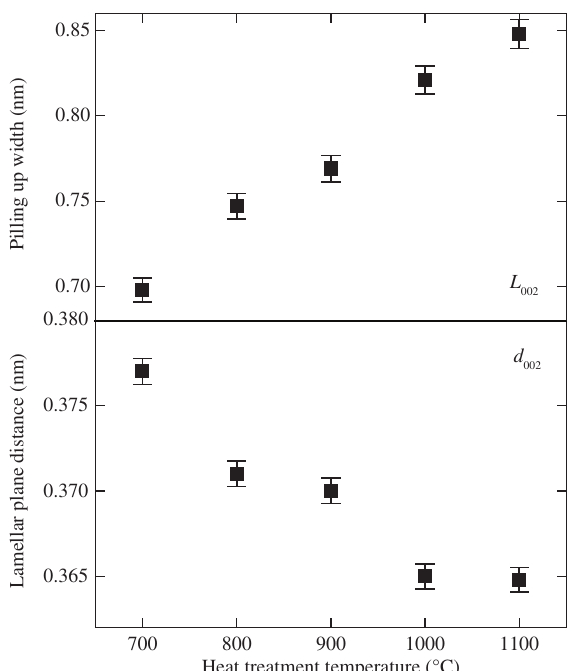
Figure 6. Specific electrochemical surface areas (SESA) for RVC electrodes and pilling up width L obtained from XRD 002 002 manufactured at different HTT (from 700 °C up to 1100 °C).